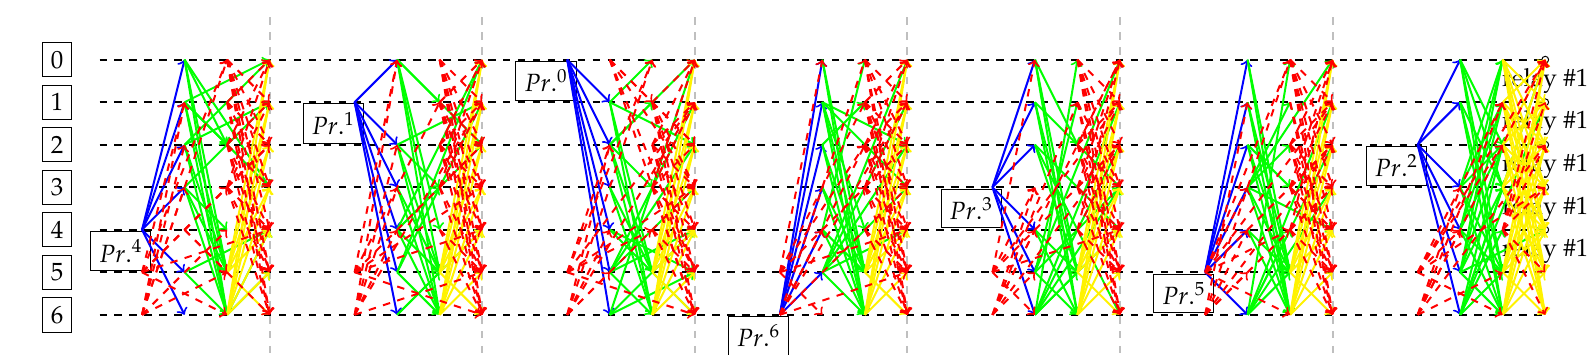
Figure 5. Scenario P 1 with N = 4 and t max = 10 (block is generated in last view). Optimal value of 1400 is found.